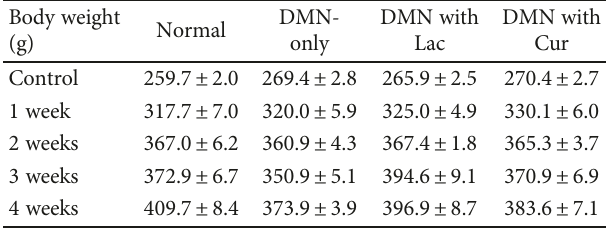
Table 1: Measurement of body weight in four experimental